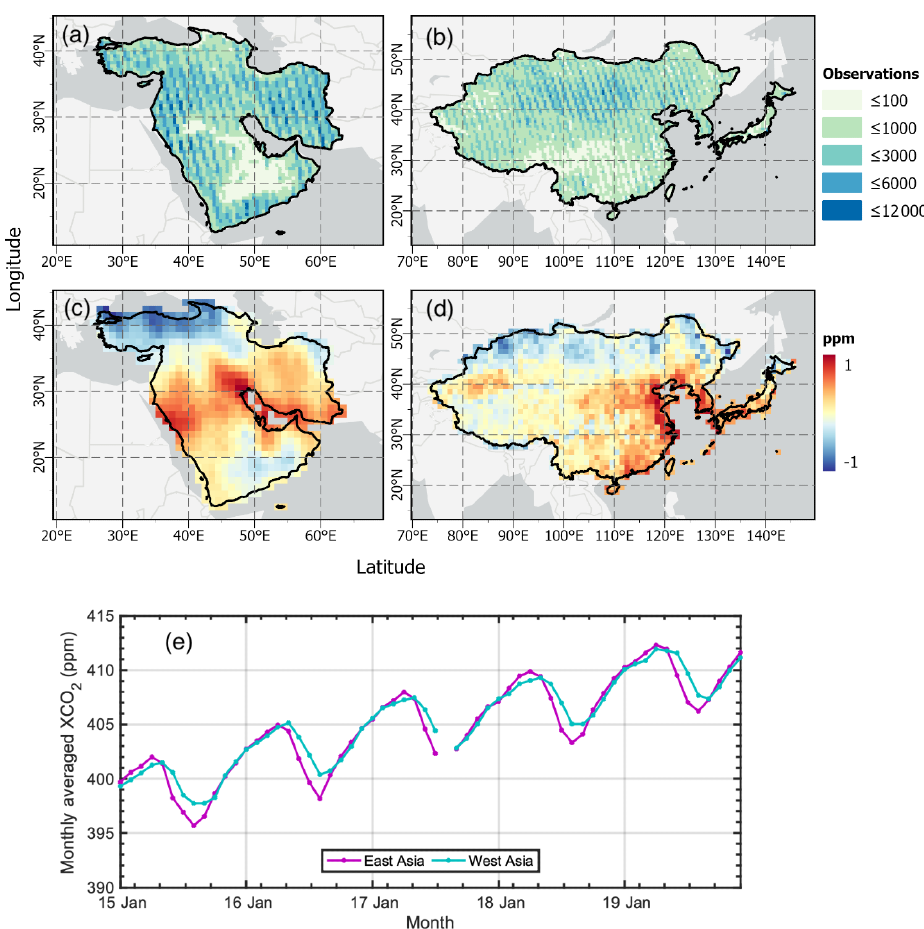
Figure 3. Number of observations in each cell of a 0.5 × 0.5 ◦ grid for a period of 5 years from 2015 to 2019 over (a) West Asia and (b) East Asia; the 5-year mean of XCO 2 anomalies calculated using OCO-2 retrievals over (c) West Asia and (d) East Asia; and (e) the monthly averaged XCO 2 concentration from 2015 to 2019 over East and West Asia. (The base map was sourced from